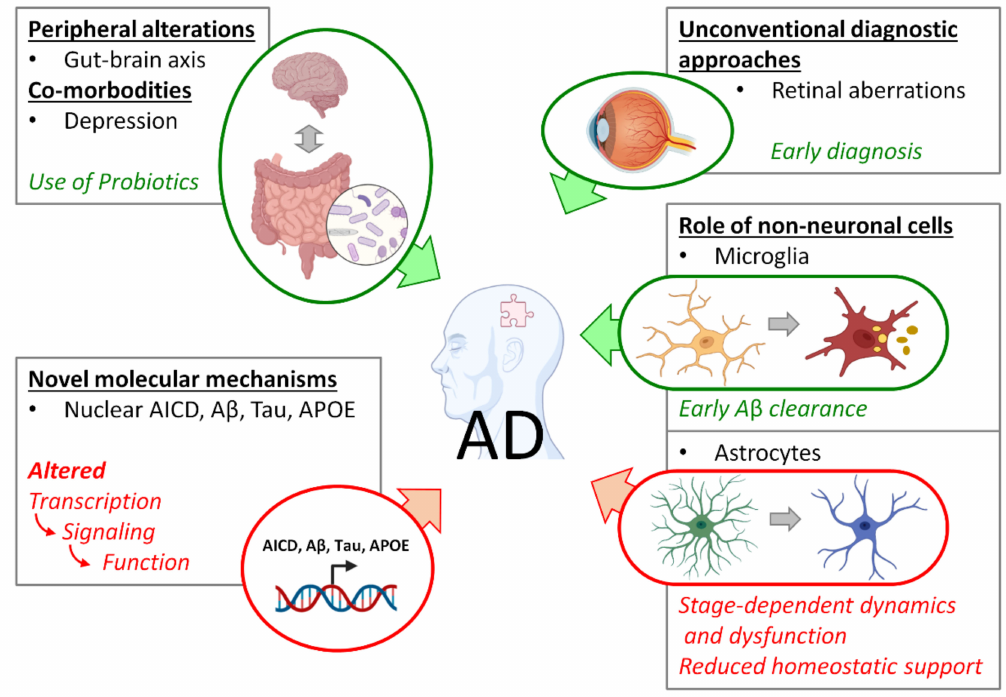
Figure 1. Spectrum of early AD-related phenomena addressed in this Special Issue. Green forms and arrows indicate positive interactions; red forms and arrows indicate negative